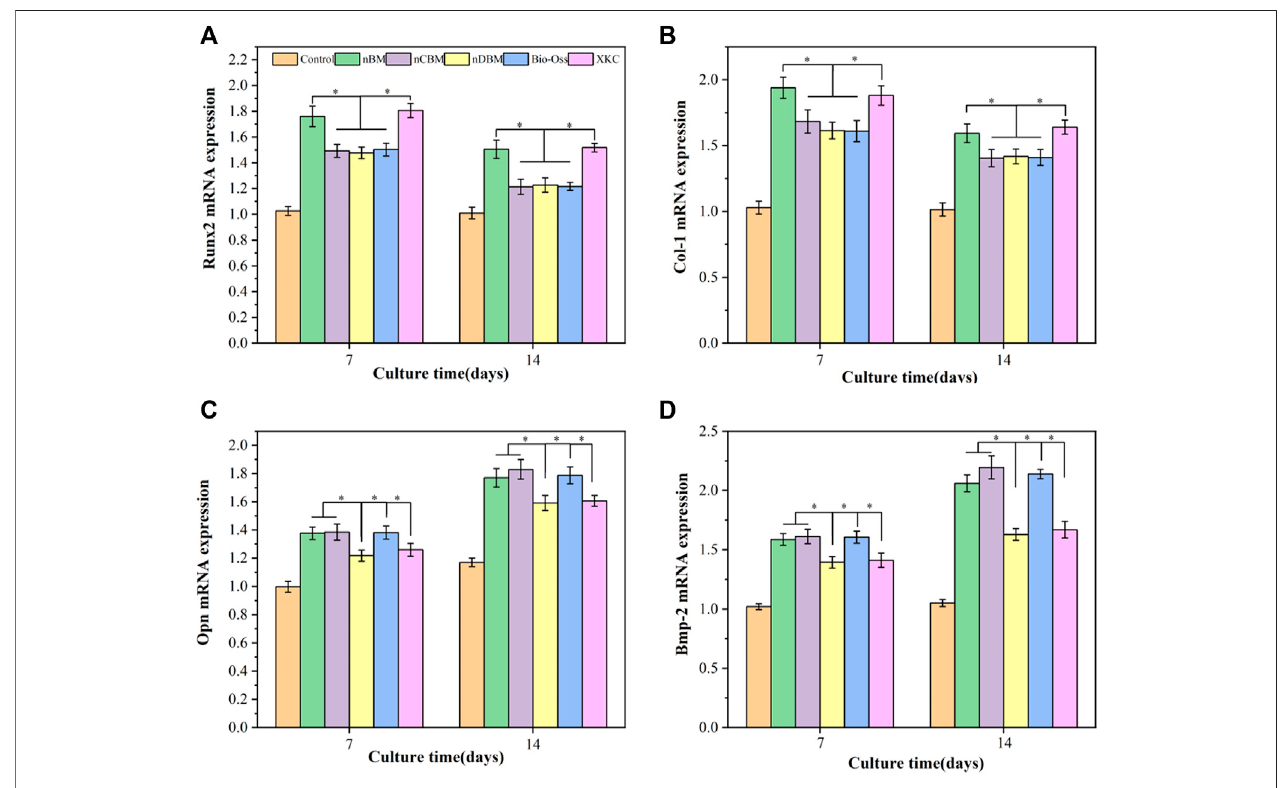
FIGURE 12 | qRT-PCR analysis of Runx2 (A) , Col-I (B) , Opn (C) , and Bmp-2 (D) in BMSCs cultured on different bone powders for 7 and 14 days. * p < 0.05.